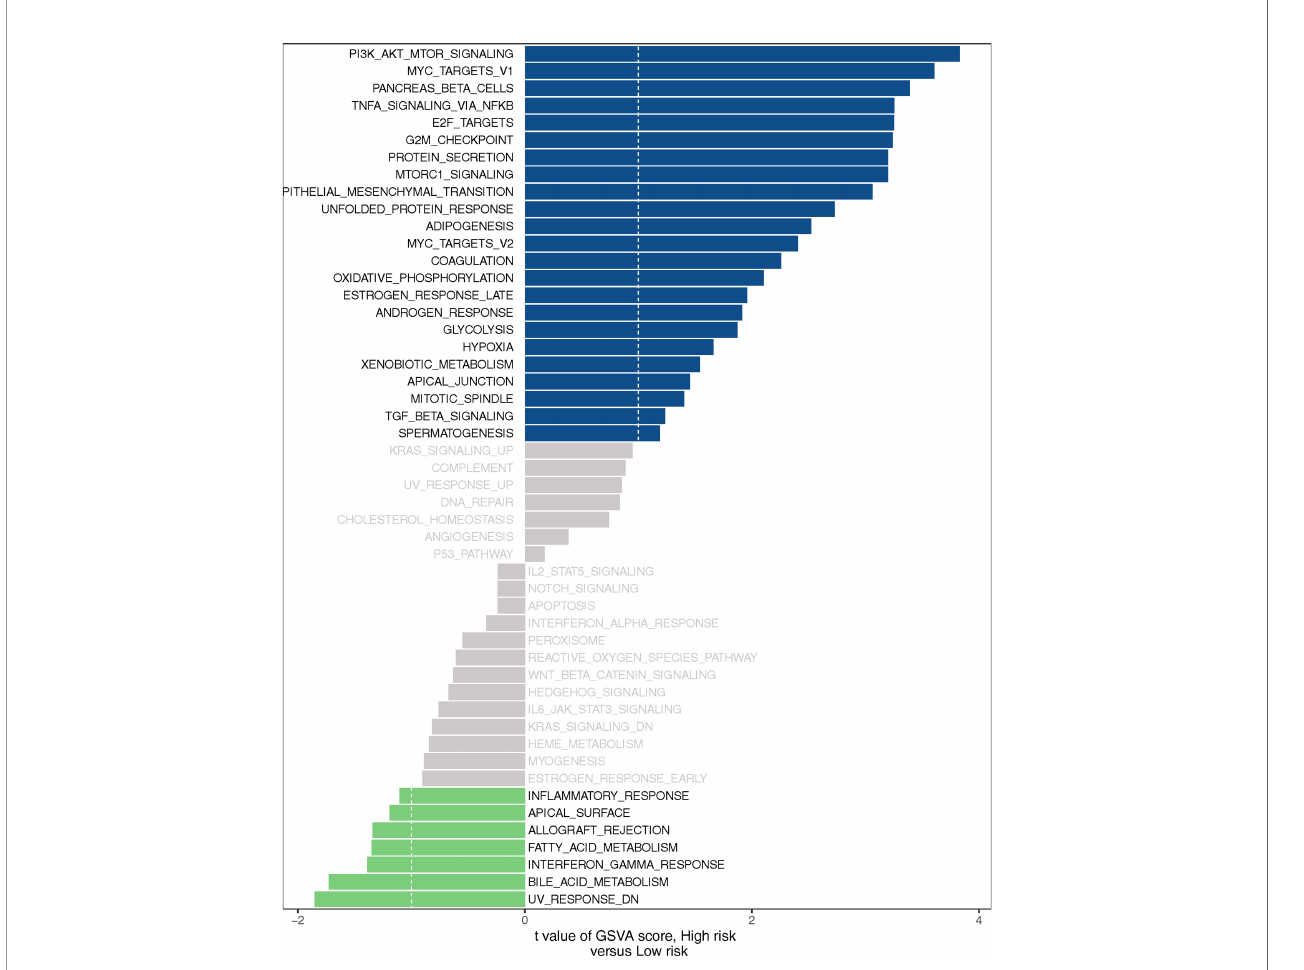
FIGURE 7 | Certain cancer-related and immunologic characteristics modulated by the LMR-lncRNA